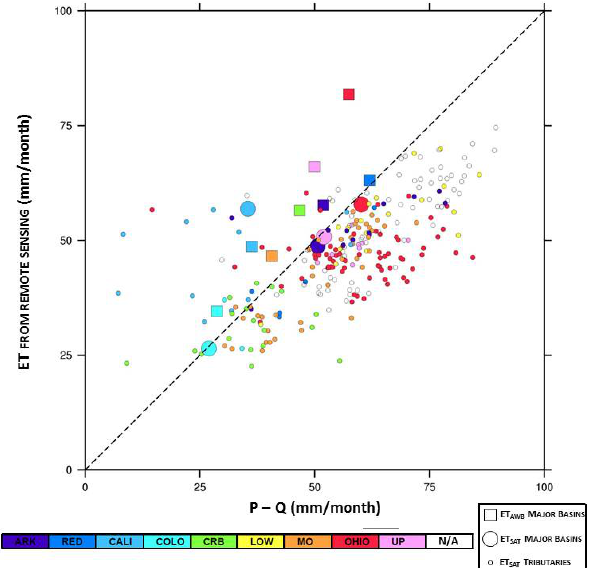
Fig. 5. Estimates of mean monthly evapotranspiration by an at- mospheric water balance (ET AWB – Sect. 2.2.1) in squares, and through satellite data (ET SAT – Sect. 2.2.2) in circles compared with the residual of precipitation, P , minus streamflow, Q , for the major basins and smaller tributaries (smaller circles). Shaded areas denote the domain within which ET was estimated, such that un-shaded circles represent ET from tributaries outside the major basins.